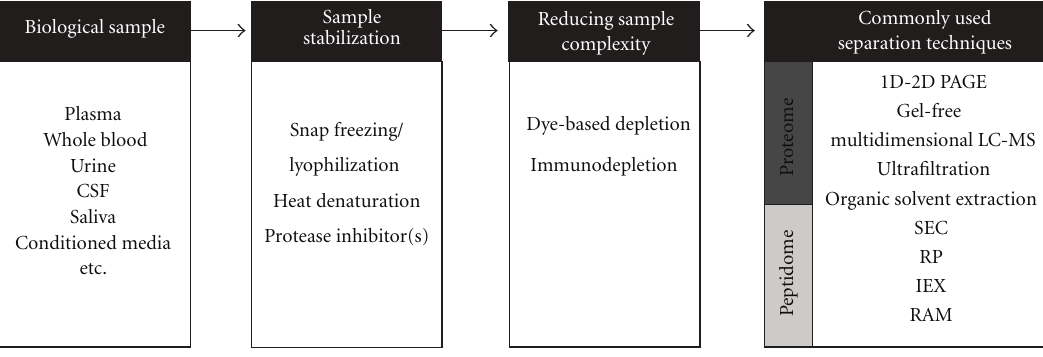
Figure 2: Schematic overview of methods and techniques used in proteome and peptidome analyses for sample preparation prior to LC